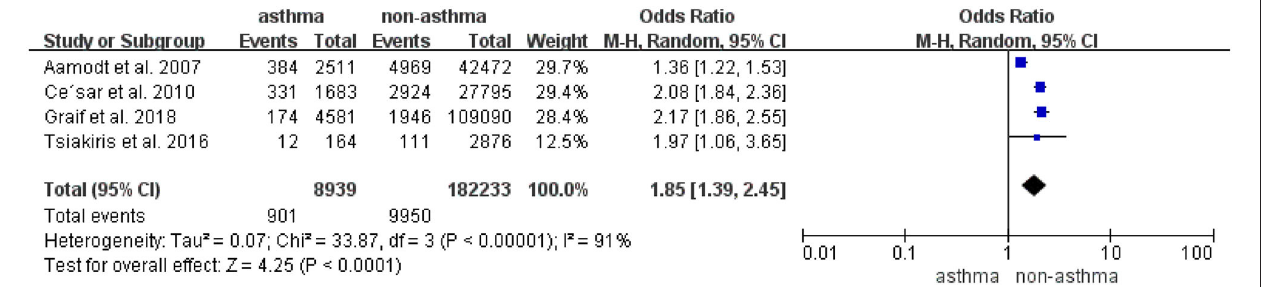
FIGURE 3 | Odds of migraine in patients with asthma in the case-control and cross-sectional studies.